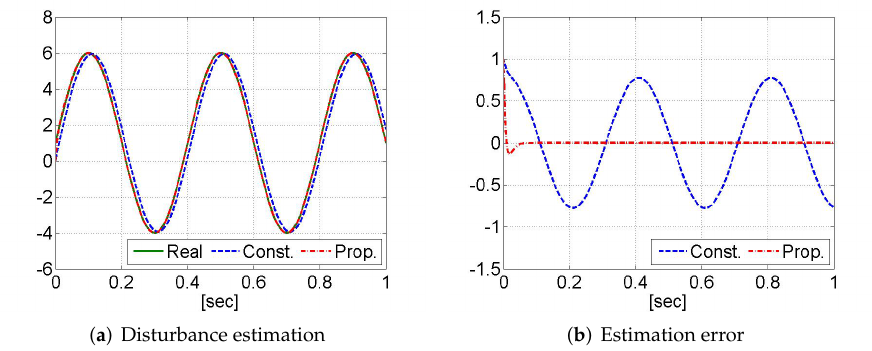
Figure 1. Simulation results of a numerical